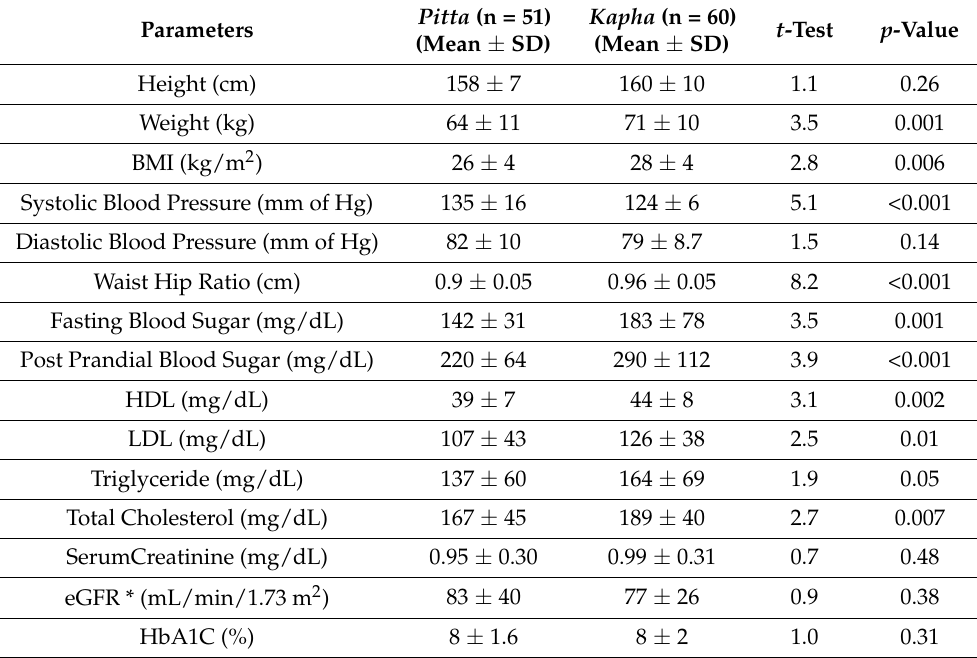
Table 1. Showing anthropometric and biochemical parameters of type 2 diabetes subjects as per Prakriti.